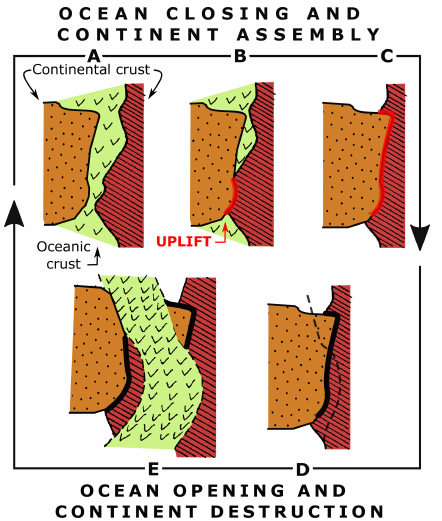
Figure 9. Ocean closing and opening cycle (modified from Wil- son, 1966). (a) A closing ocean; (b) first contact between two op- posite continental coasts; (c) ocean closure and final collision of opposite continental coasts; (d) a hypothetical line (dashed) along which a new continental rupture would engender a younger ocean to re-open; (e) a new ocean opening after the break-up of an old continent.